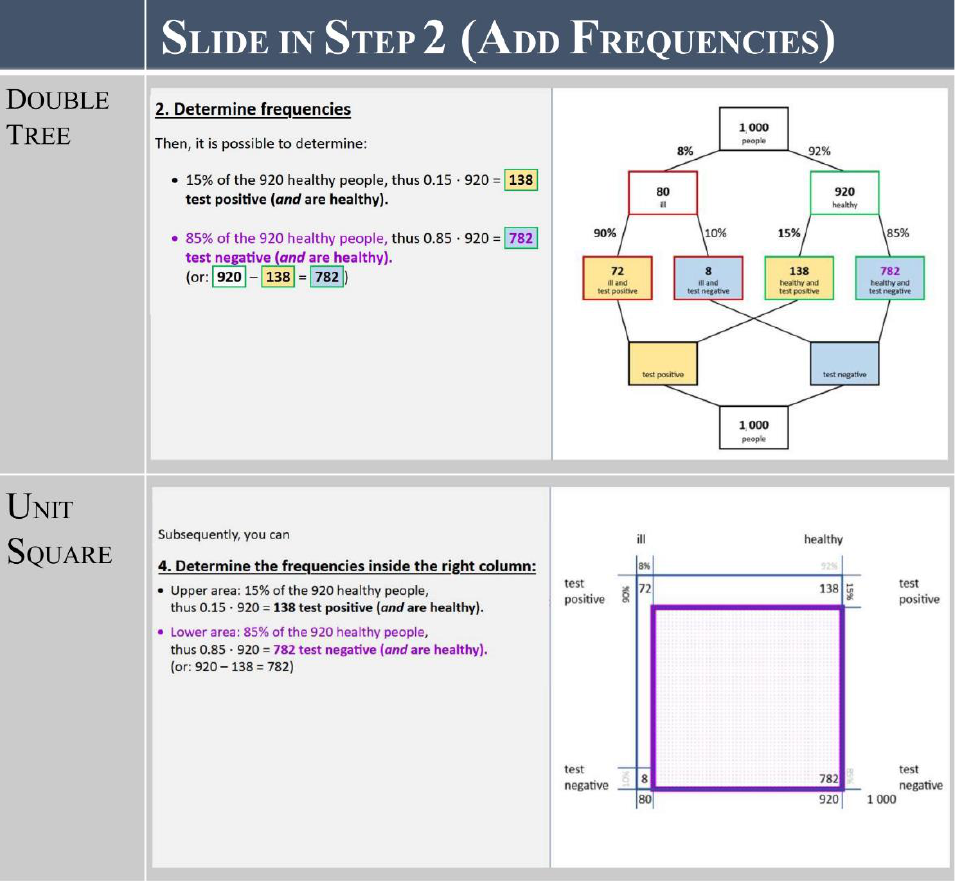
Figure 4. Implementation of multimedia principles (segmenting, signaling, temporal and spatial contiguity) in one slide within step 2 (add frequencies). Firstly, the new text appears (lowest bullet point on the left-hand side) followed by the new element in the visualization (new number on the right-hand side). Corresponding features are highlighted in purple.